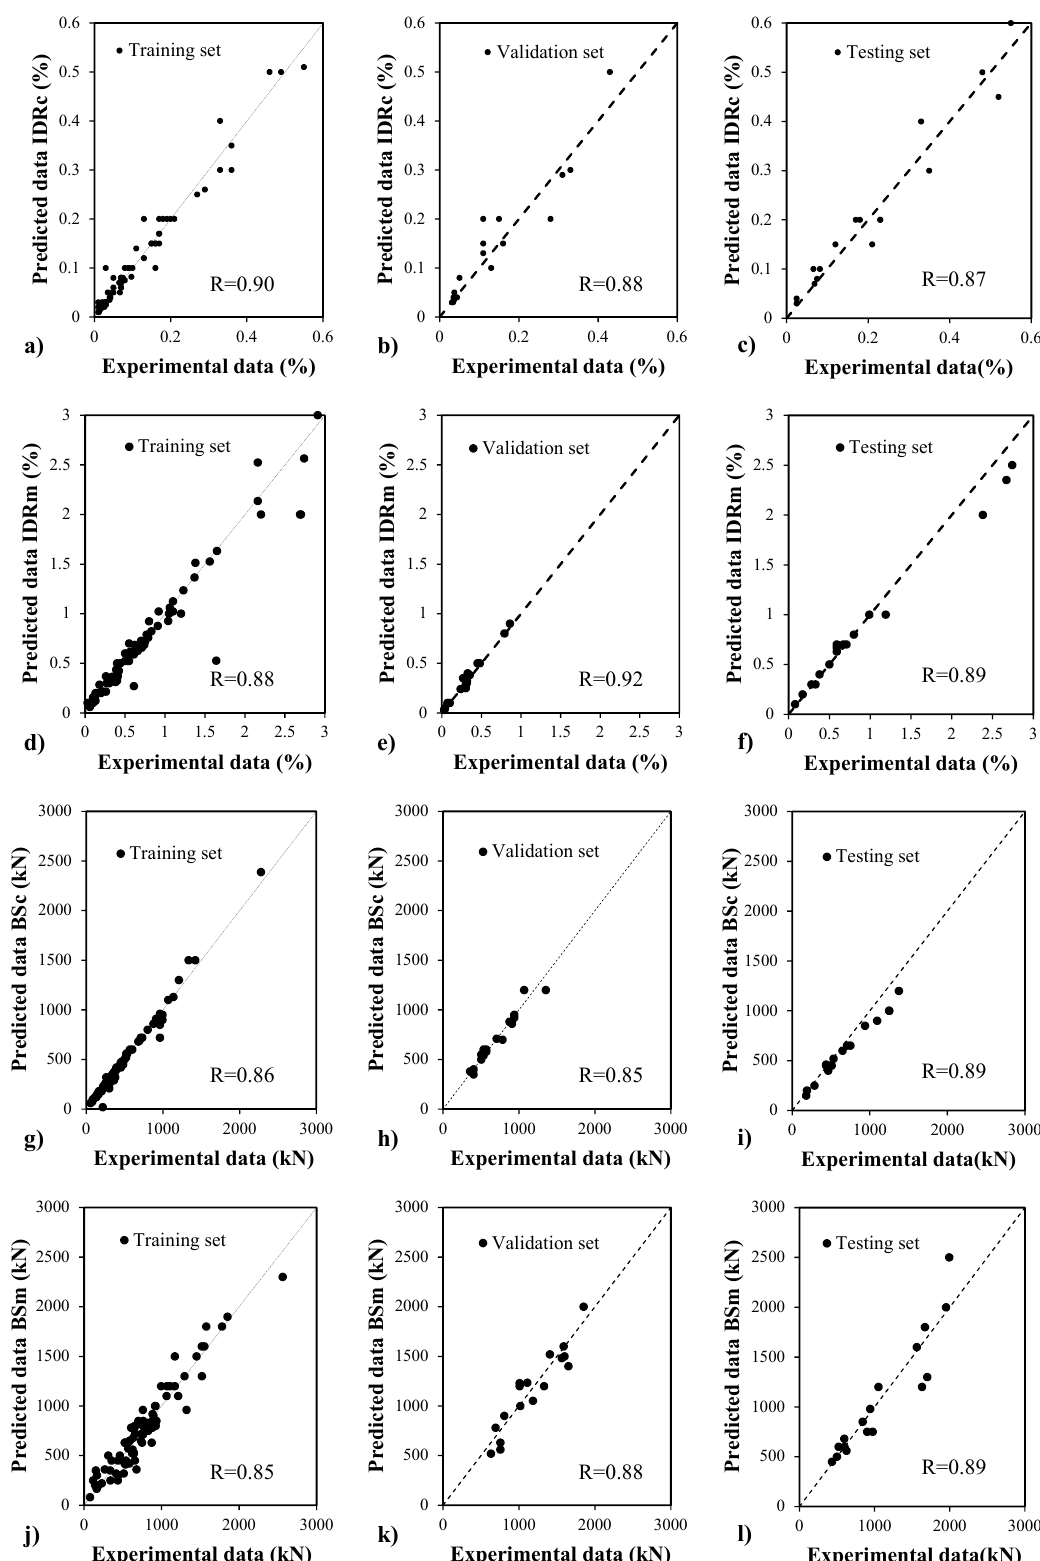
Figure 2. Results of neural network processing for 5 hidden neurons.( a ) for IDRc training set; ( b ) for IDRc validation set; ( c ) for IDRc testing set; ( d ) for IDRm training set; ( e ) for IDRm validation set; ( f ) for IDRm testing set; ( g ) for BSc training set; ( h ) for BSc validation set; ( i ) for BSc testing set; ( j ) for BSm training set; ( k ) for BSm validation set; ( l ) for BSm testing set;.